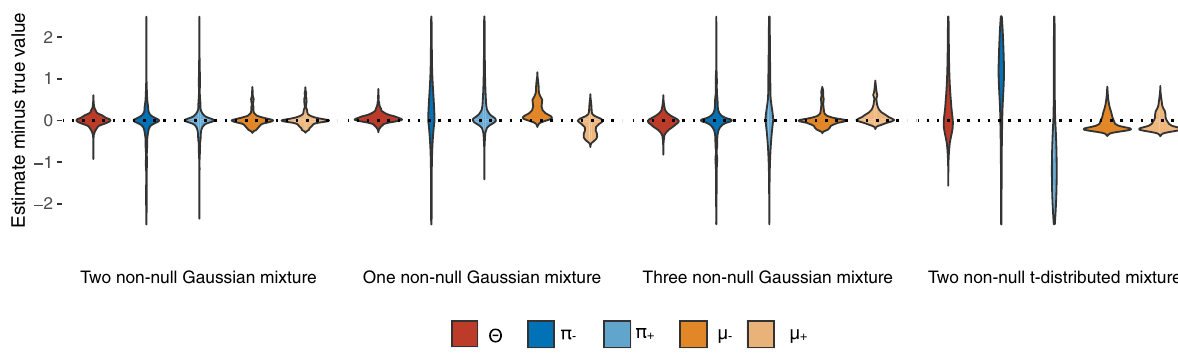
Fig. 1 Representative simulation results of total genetic contribution assessment (TGCA) under different true models. 200 independent Z-scores for a single genetic variant were drawn from a mixture distribution with (1) two non-null Gaussian components 0 : 25 N ð μ (2) one non-null Gaussian component 0.5 N (0,1) + 0.5 N ( μ + , σ 2 ), (3) three non-null Gaussian components 0 : 25 N ð μ ; σ 2 0 : 125 N ð μ Þ , and (4) two non-null heavy-tailed t -distributed components 0.25[ t (1) + μ − ] + 0.5 N (0,1) + 0.25[ t (1) + μ + ], respectively. The 3 þþ